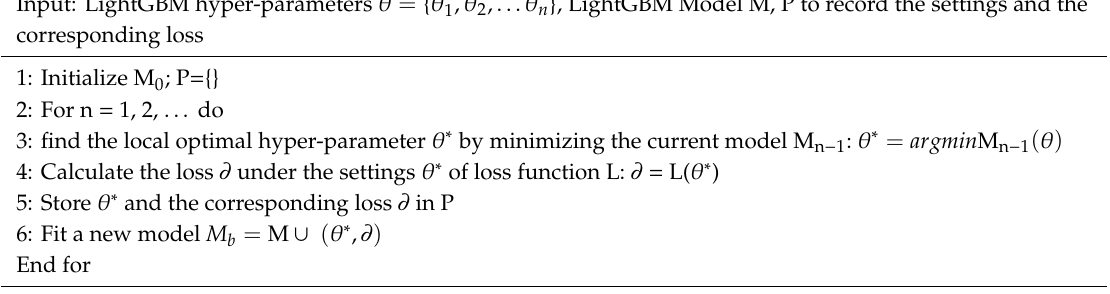
Algorithm 1: LightGBM via hyper-parameters optimization model